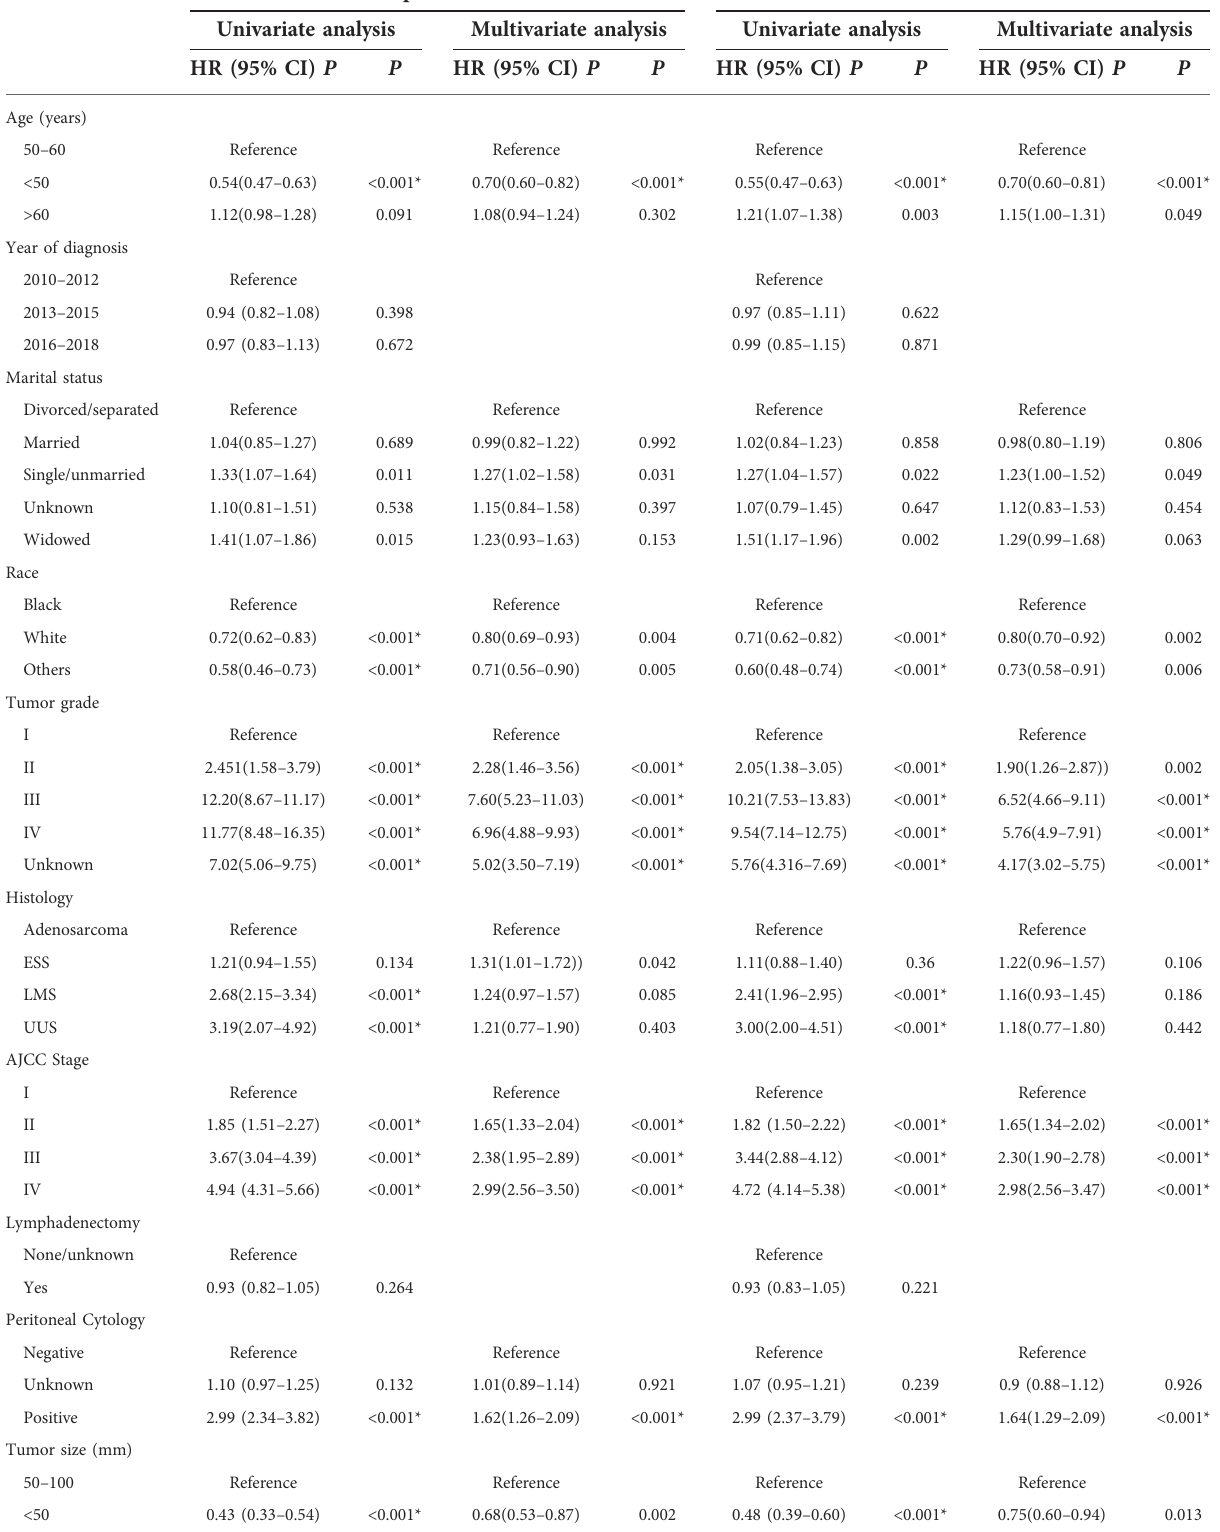
TABLE 3 Univariate and multivariate analysis of predicting CSS and OS after IPTW-adjusted in stage I-IV US patients.